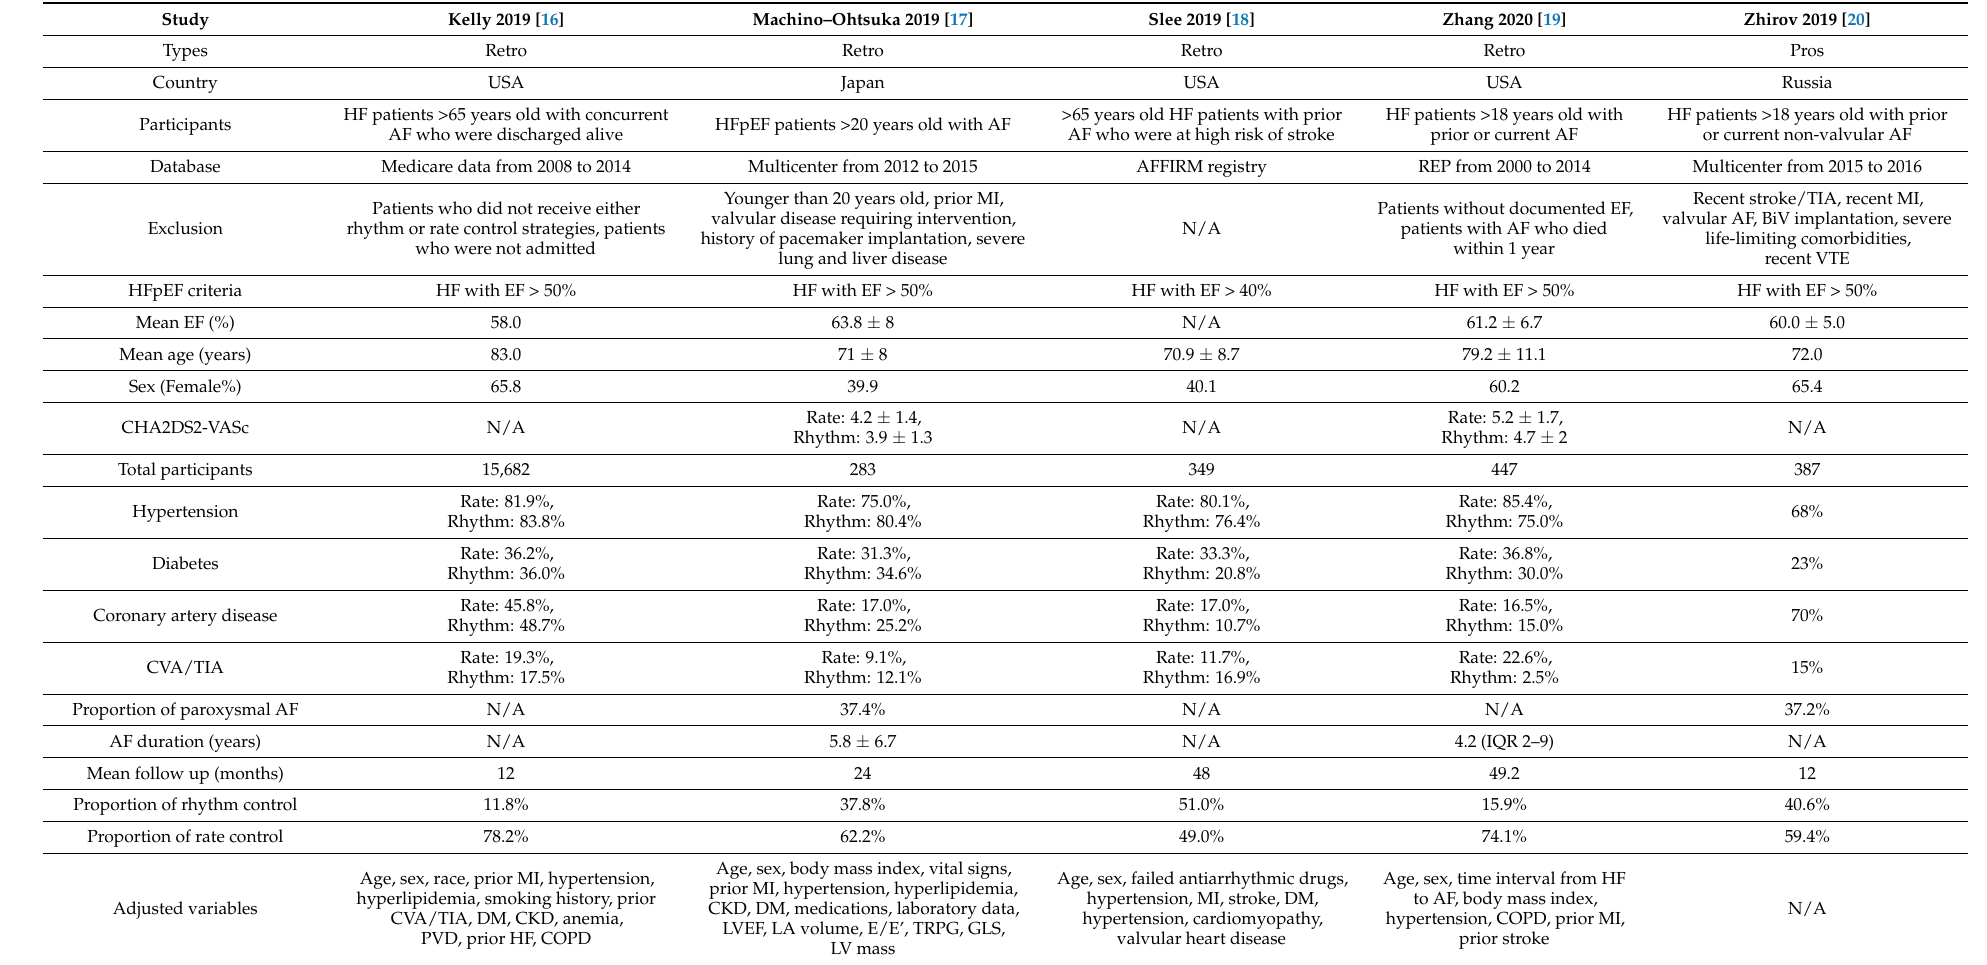
Table 1. Characteristics of included